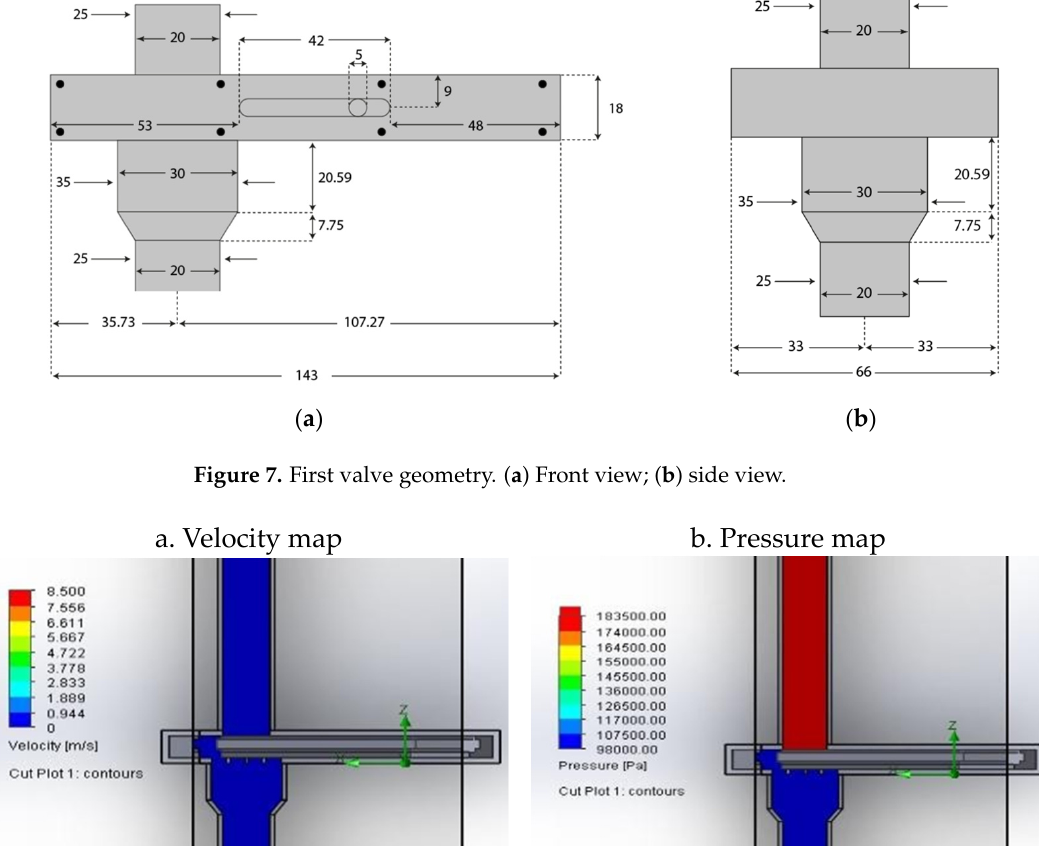
Figure 8. First valve geometry with 10% opening.